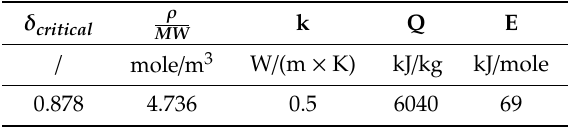
Table 2. The properties used for the spontaneous ignition sensitivity